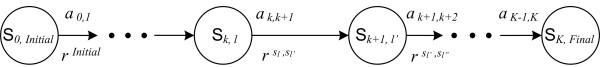
State transition model for a sub-image.